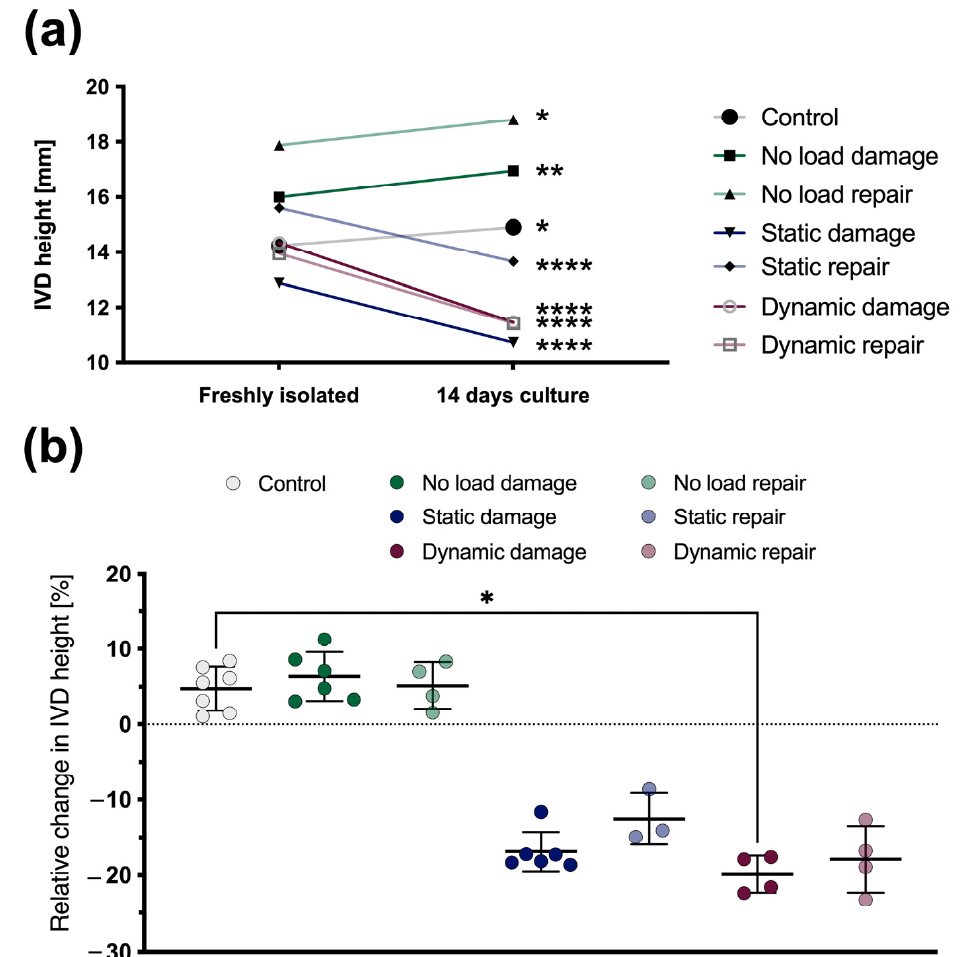
Figure 3. ( a ) Absolute IVD height changes either without additional mechanical loading, under static loading, or under complex dynamic loading for 14 days. Mean, n = 3–7. ( b ) Relative IVD height changes either without additional mechanical loading, under static loading, or under complex dynamic loading for 14 days. Mean ± SD, n = 3–7, p -value: * < 0.05, ** < 0.01, **** < 0.0001.